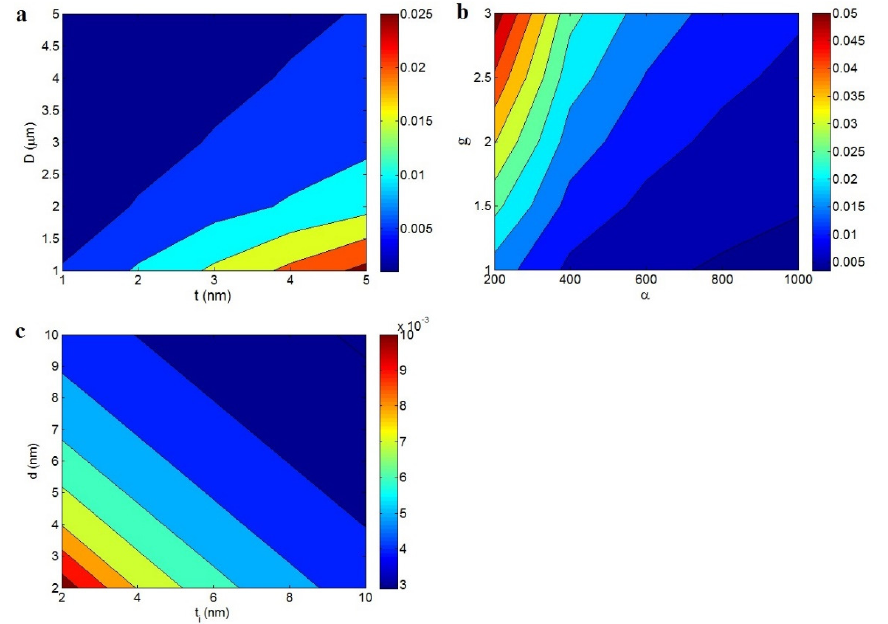
Figure 1. Stimuli of ( a ) t and D , ( b ) α and g , and ( c ) t i and d on the percolation inception based on Equation (7).